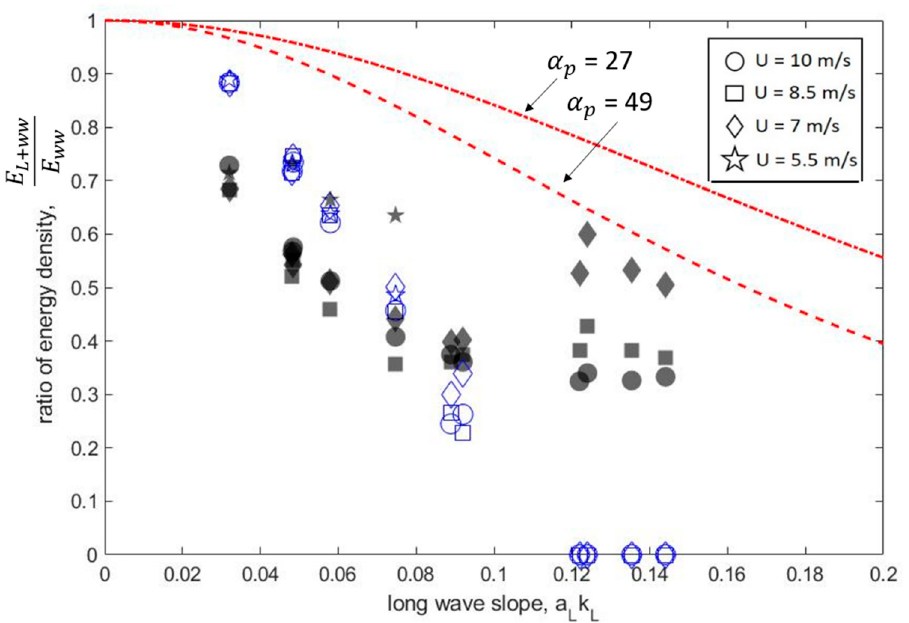
Figure 7. Results of the modified CBM model. Black symbols represent the energy ratios directly from experimental data, as shown in Figure 4. The red, dashed line and red, dot-dashed lines indicate the maximum and minimum limits of the original CBM results, respectively, using Equation (7) instead of Equation (21) to quantify τ L using directly quantified values of α P . Blue, open symbols represent the modified model results, i.e., the model energy ratio as quantified from Equation (18) using the new formulation for τ L given in Equation (21), and using τ t = τ tot − τ L to calculate the turbulent stress, and using the directly quantified values of α P . Model results for which E L + ww value of 𝜏 (cid:3013) > 𝜏 (cid:3047)(cid:3042)(cid:3047) or 𝜏 (cid:3047) = 0 , representing total wind wave suppression.